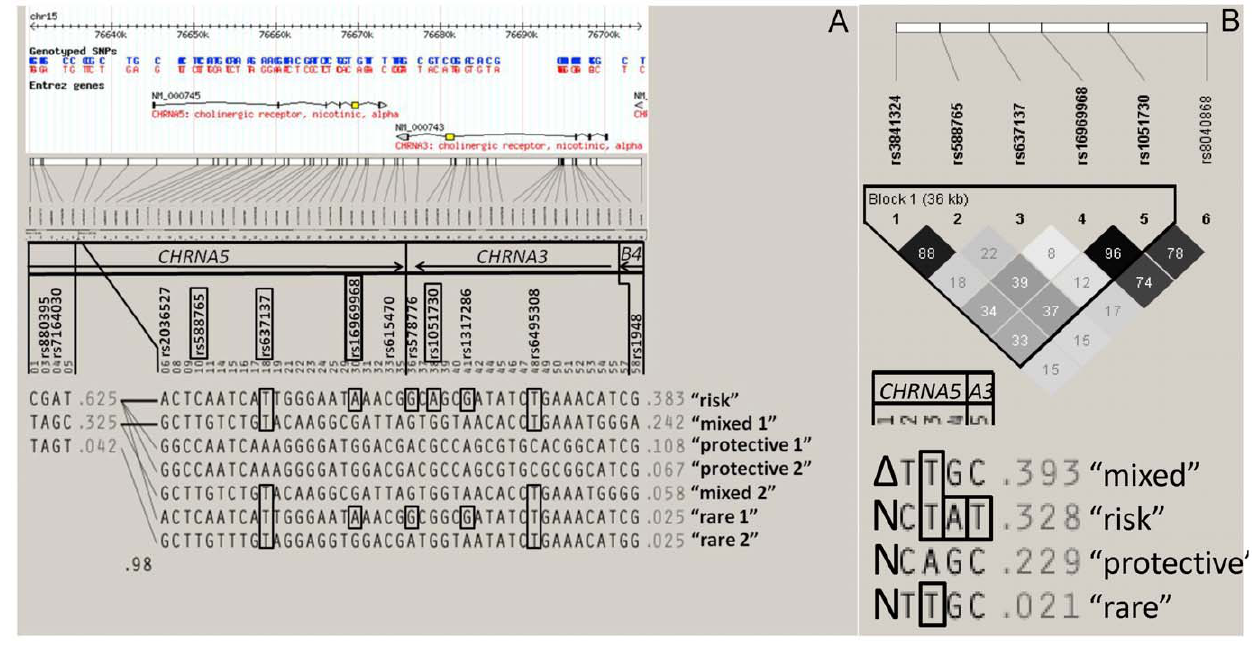
Figure 1. Haplotype and LD structure of CHRNA5-CHRNA3 genes in Europeans. Haploview 4.2 [23] was used to download the version 2, release 21 CEU dataset between Chr15:76638000-76705000 from the HapMap project. The method of confidence intervals was used to generate haplotype blocks [24]. (A) The relative position of HapMap SNPs, numbered 1–58, along each gene is shown schematically at the top. Five major ( . 5%) and two rare ( , 5%) haplotypes of the gene cluster are shown with risk alleles in each haplotype associated with NA boxed in black.